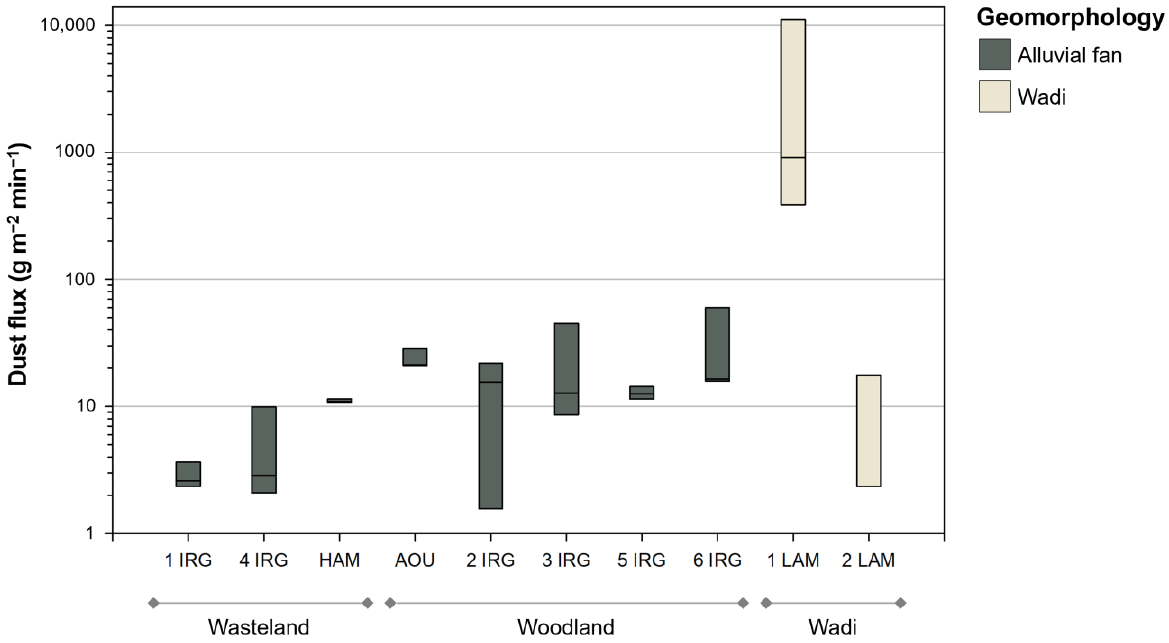
Figure 5. Mass flux for geomorphology per site (each site = three tests). Solid lines show the medians. Related to (a) surface and (b) LCC are different mean values for a variable number of tests (Table 4). Table 4. Mean horizontal dust flux and organic carbon flux for surface and LCC categories.